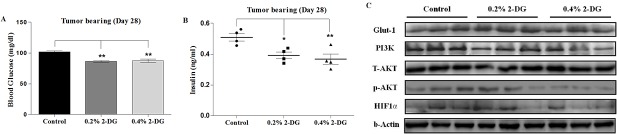
Dietary 2-DG reduces blood glucose, serum insulin and PI3K/AKT signalling.2-DG administration reduces (A) blood glucose, (B) serum insulin in EAC tumor bearing mice (day 28) as observed in the non-tumor bearing mice shown in Fig 2E and 2F), and down-regulated (C) PI3K/Akt signalling in tumors. Western blot results revealed reduced expression of PI3K, phosphorylated-Akt and HIF-1α. No changes were observed in the expression levels of Glut-1 and T-Akt. β-Actin was used as loading control.